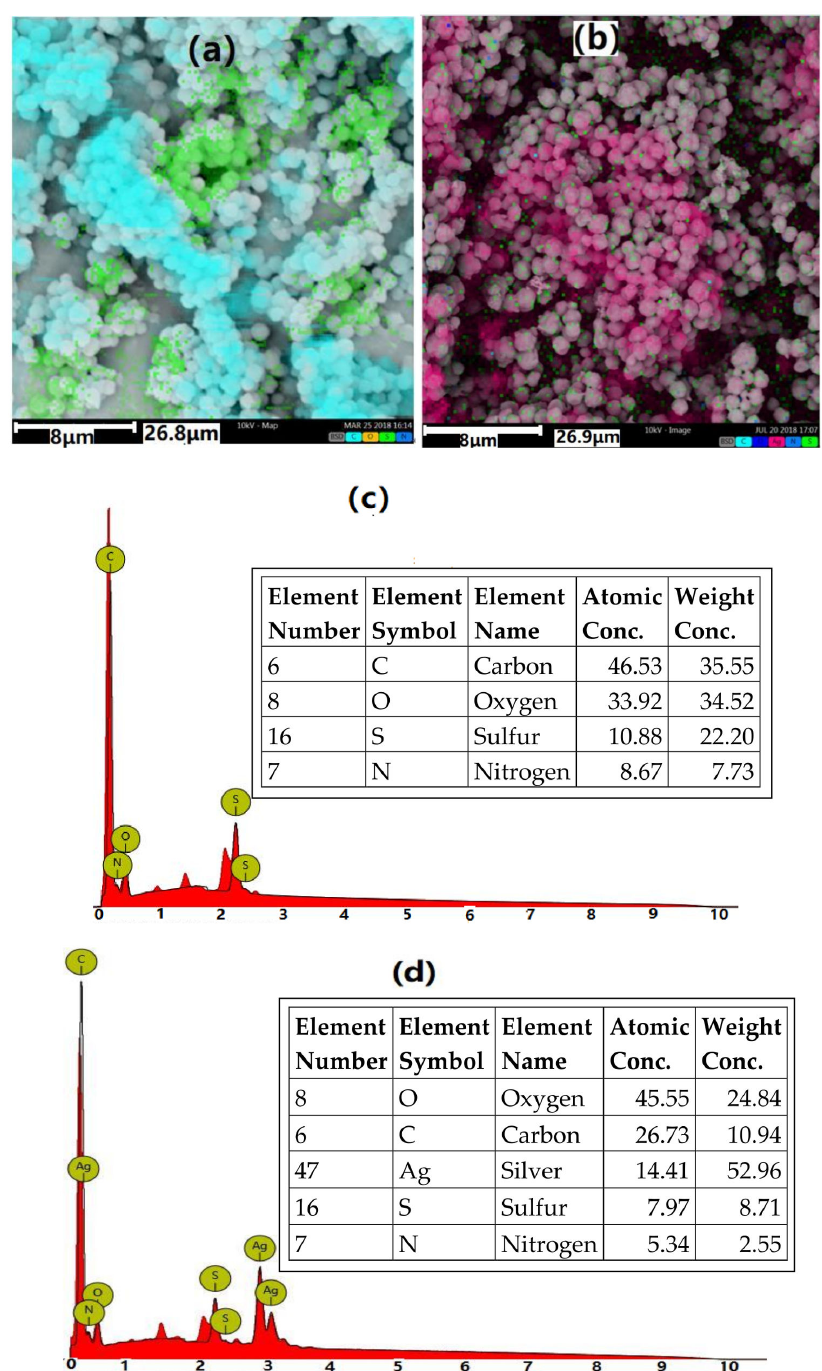
Figure 10. SEM image of BA-PGMA ( a ) and BA-PGMA-Ag ( b ), EDS spectrums of BA-PAMA ( c ) and BA-PGMA-Ag ( d